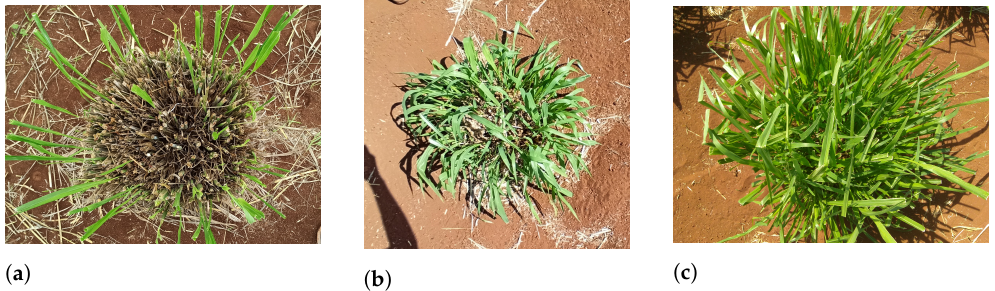
Figure 4. Dataset examples with their respective ground-truth value: ( a ) Regrowth density of 10. The image was taken with Redmi Note 8 Pro. ( b ) Regrowth density of 50. The image was taken with Redmi Note 8 Pro. ( c ) Regrowth density of 100. The image was taken with Moto G